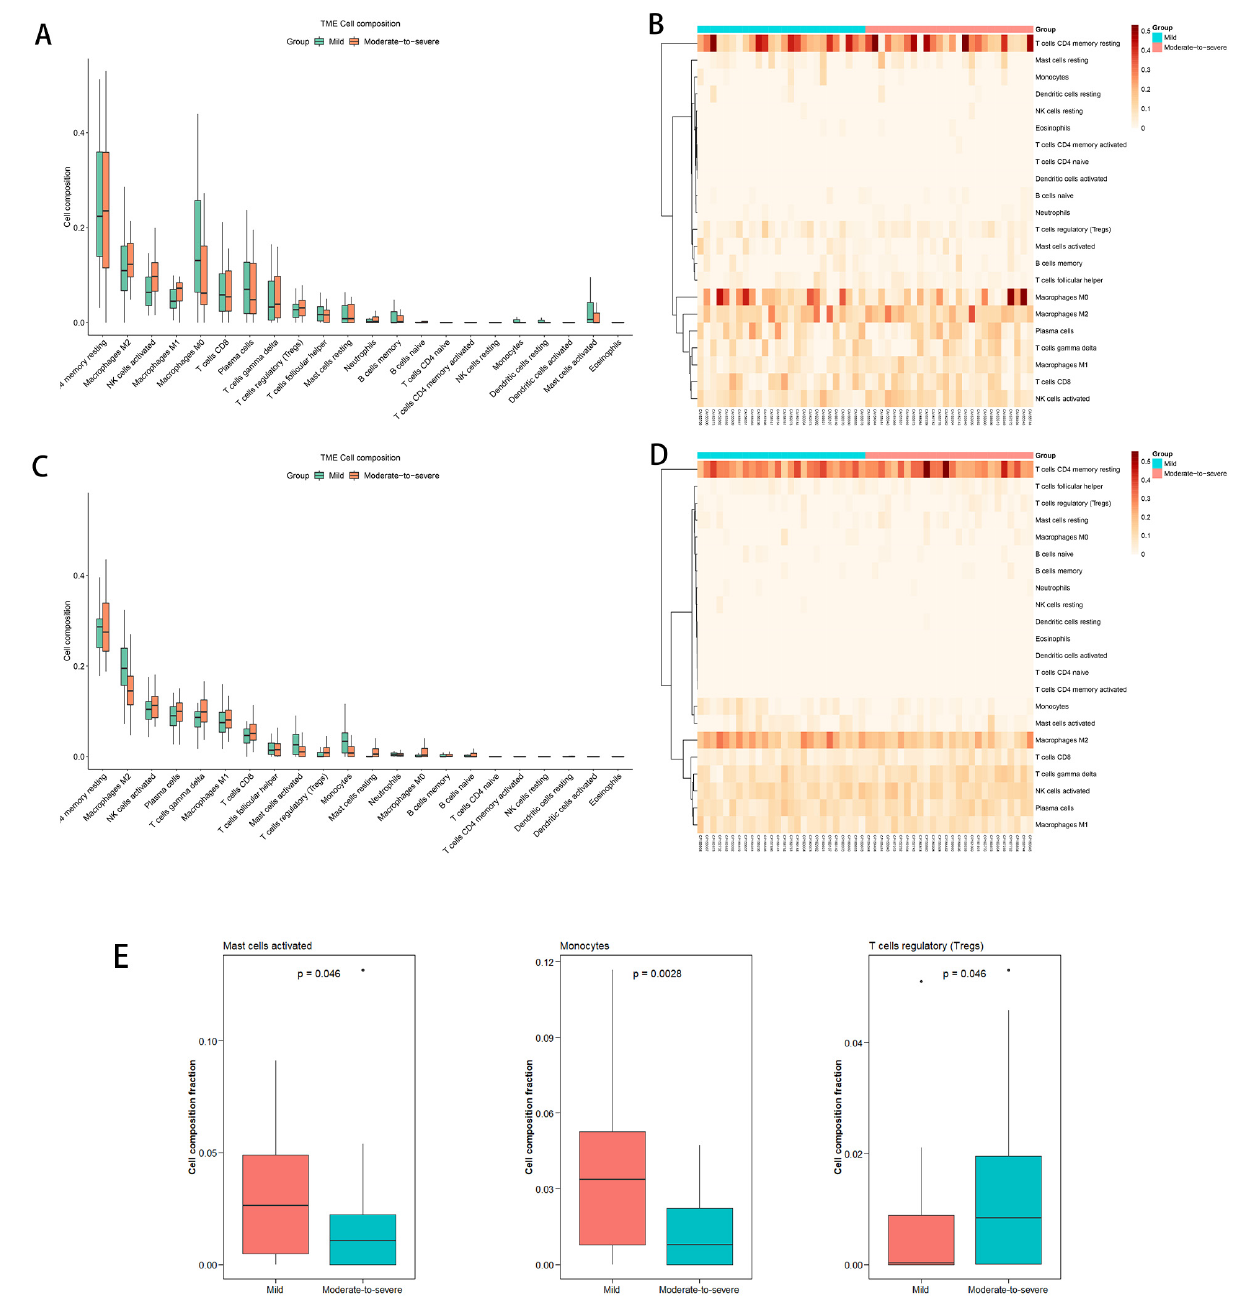
Figure 5. CIBRSORT comparing immune cell populations between patients with moderate-to-severe or mild inflammation and fibrosis based on analysis of ( A , B ) tumor tissue or ( C , D ) para-carcinoma tissue. ( E ) CIBERSORT comparing levels of mast cells activated, monocytes and regulatory T cells in para-carcinoma tissues between patients with moderate-to-severe, or mild inflammation and fibrosis.